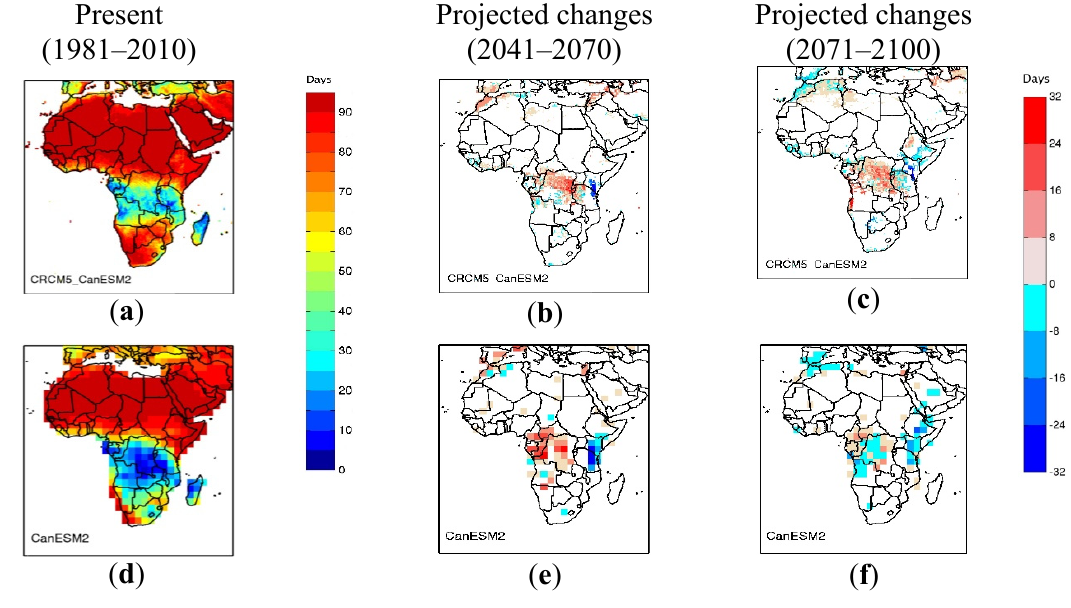
Figure 8. Same as Figure 6, but for the mean number of dry days for austral summer.